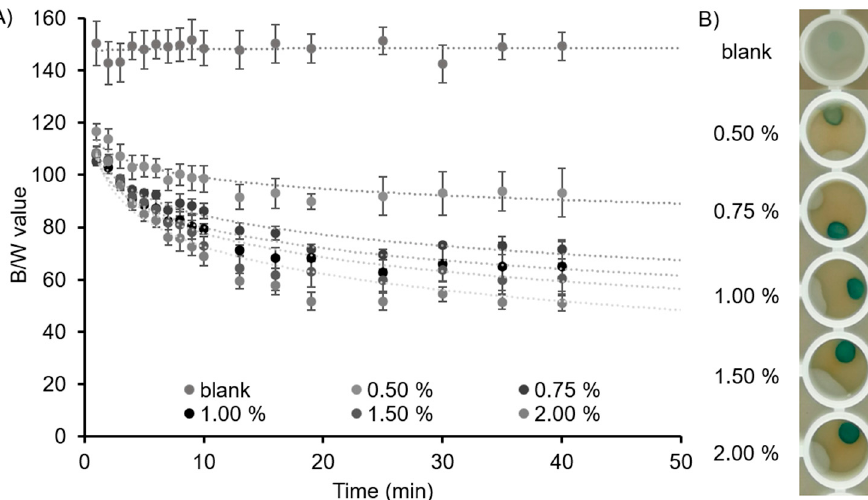
Figure 3. Optimisation of the alginate concentration for the fabrication of alginate beads. ( A ) Black and white values of the beads with alginate 0.5, 0.75, 1, 1.5 and 2%, after adding an artificial sweat solution with a lactate concentration of 60 mM at different times. The blank was an alginate bead, 1.5%, after adding an artificial sweat solution without lactate, as a reference. ( B ) Pictures of beads with alginate concentrations of 0.5, 0.75, 1, 1.5 and 2% taken at 13 min, when the reaction reached a plateau. Error bars correspond to mean values ± SD (n =